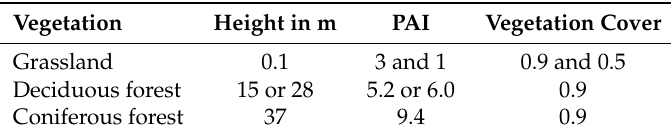
Table 1. Exemplary parameter values of HIRVAC2D runs producing LLJ. Parameters: PAI is the plant area index (vertical integral of plant area density), vegetation cover is the vegetation-covered fraction of ground surface area. Combination of parameter values result in four types of grassland, two deciduous and one coniferous forests.